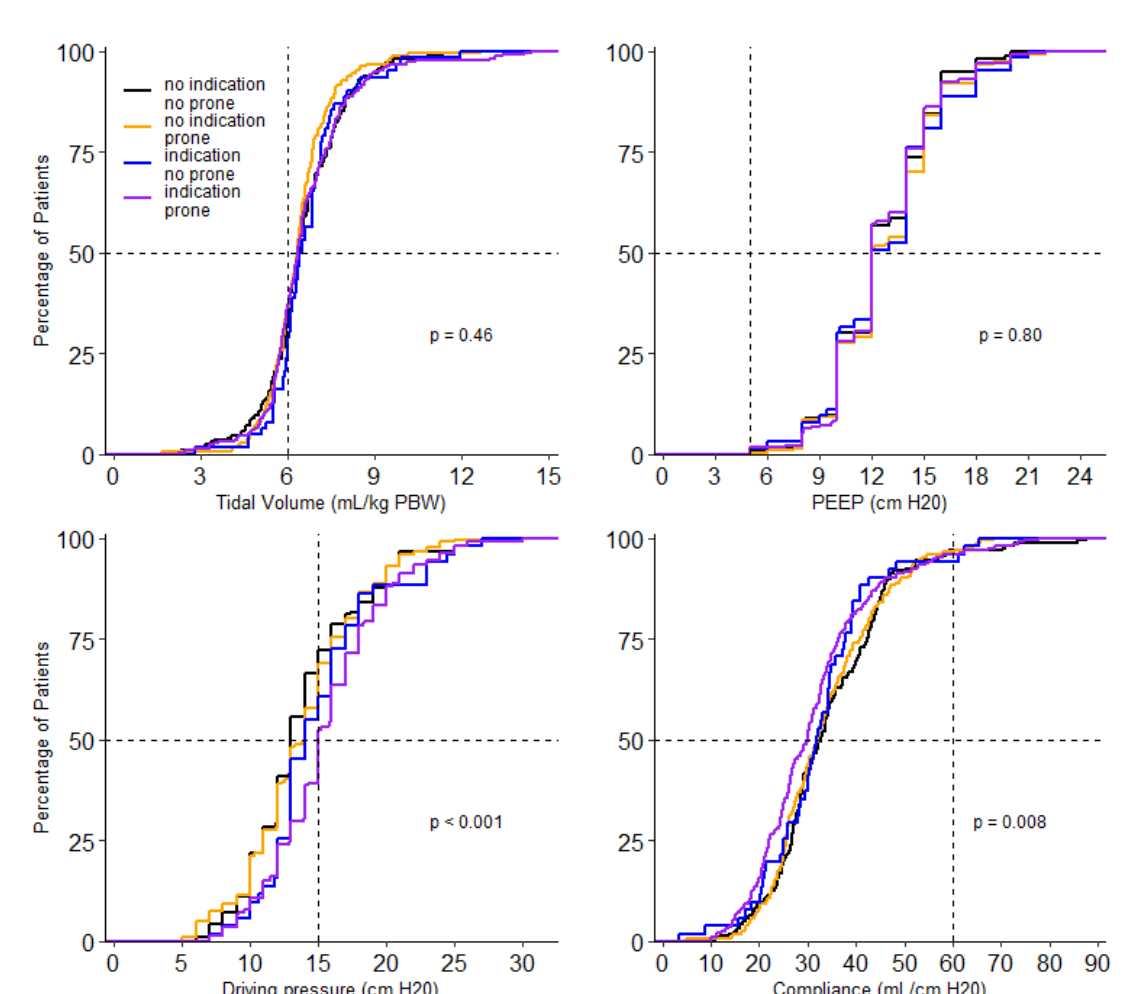
Figure 3. Cumulative distribution of ventilatory parameters on day 0. Levels of tidal volume, PEEP, driving pressure and compliance for each patient on day 0.